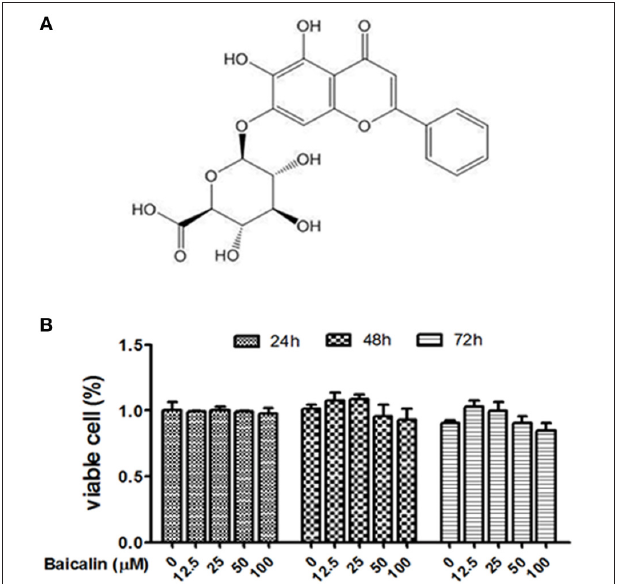
FIGURE 1 | Effect of baicalin on the viability of Raw264.7. (A) The chemical structure of baicalin; (B) Proliferation assay was conducted to assess the cytotoxic effect of baicalin on Raw264.7. Data are shown as means ± SD of three independent experiments.